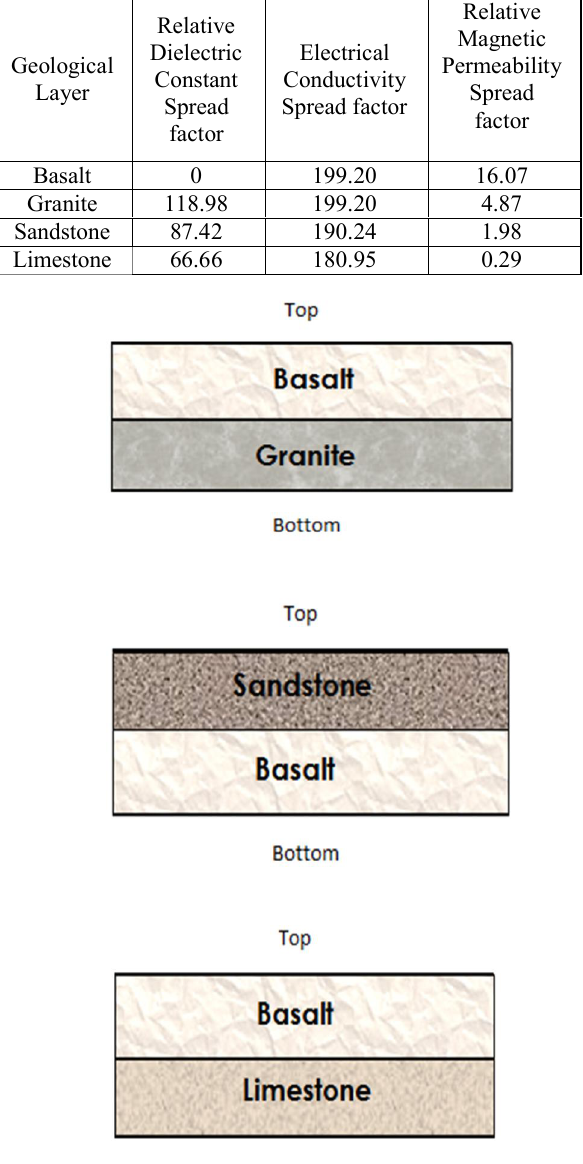
Table 2: Spread Factor (%) of each physical parameter of the four geological layers.